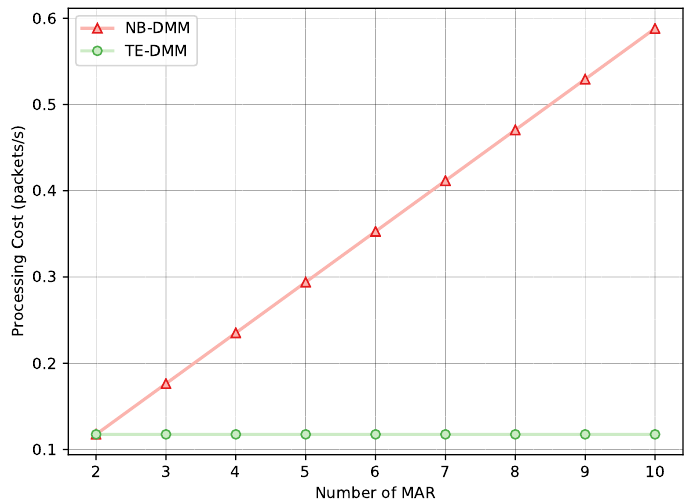
Figure 8. Processing cost depending on number of mobility anchors.